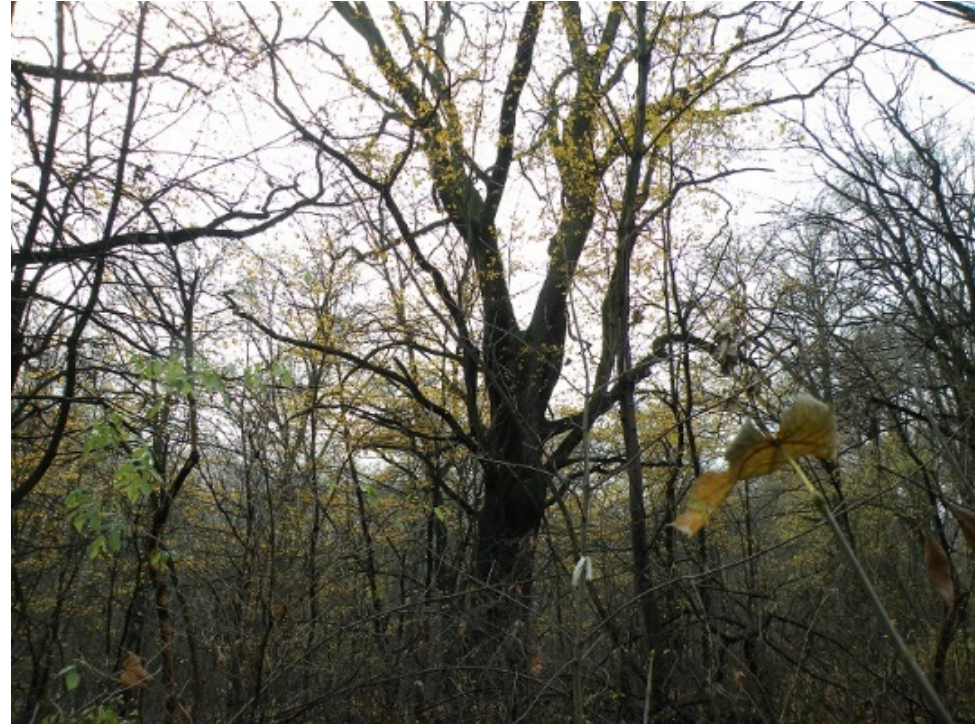
Figure 9. A “shadow” scarp’s treed grassland: the open-grown oak on the Lisia Góra scarp; the tree’s branching index Tb = 301 (comparing to μ = 81.233, σ = 75.416, n = 294).